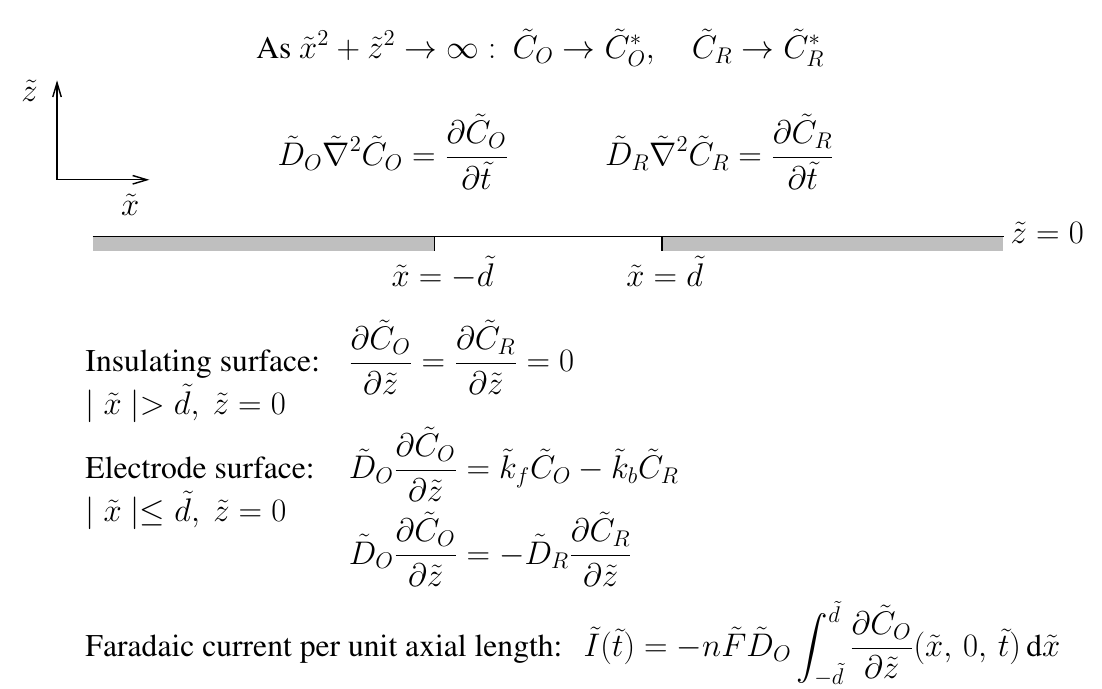
Figure 2. Schematic of the theoretical two-dimensional diffusion problem to be solved for the Faradaic current through an inlaid microband electrode. Two redox species with concentrations ˜ C and ˜ C (mol · m − 3 ) diffuse with unequal diffusion coefficients ˜ D O R ˜ D (m 2 · s − 1 ) above the electrode. Initially the bulk concentrations are uniform everywhere R and equal to ˜ C ∗ and ˜ C ∗ ; we assume these remain undisturbed as ˜ x 2 + ˜ z 2 → ∞ . On the O R surface of the electrode, | ˜ x |≤ ˜ d, ˜ z = 0 , the boundary conditions model the redox reaction in Equation (1) and conservation of matter. The Faradaic current per unit axial length, ˜ I (˜ t ) (A · m − 1 ), through the electrode is proportional to the integral of the diffusive flux at the electrode